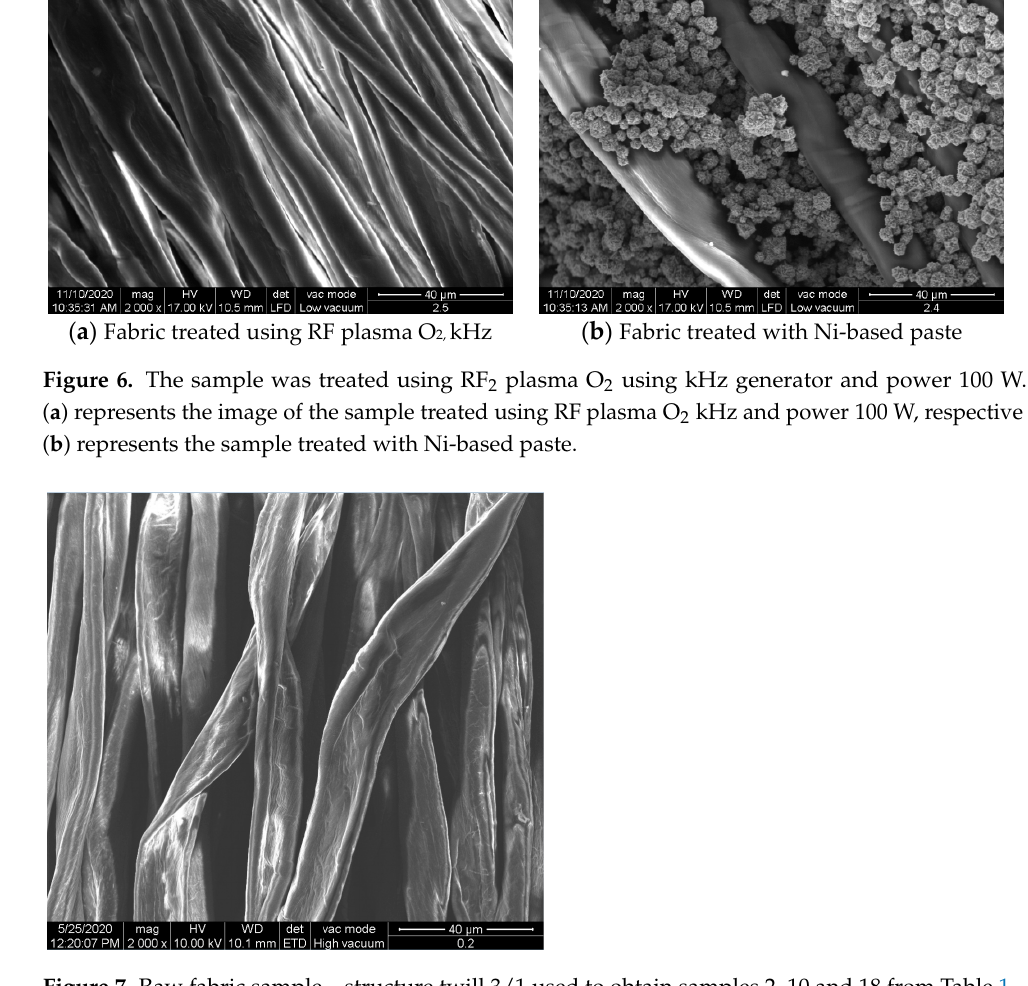
Figure 7. Raw fabric sample—structure twill 3/1 used to obtain samples 2, 10 and 18 from Table 1.